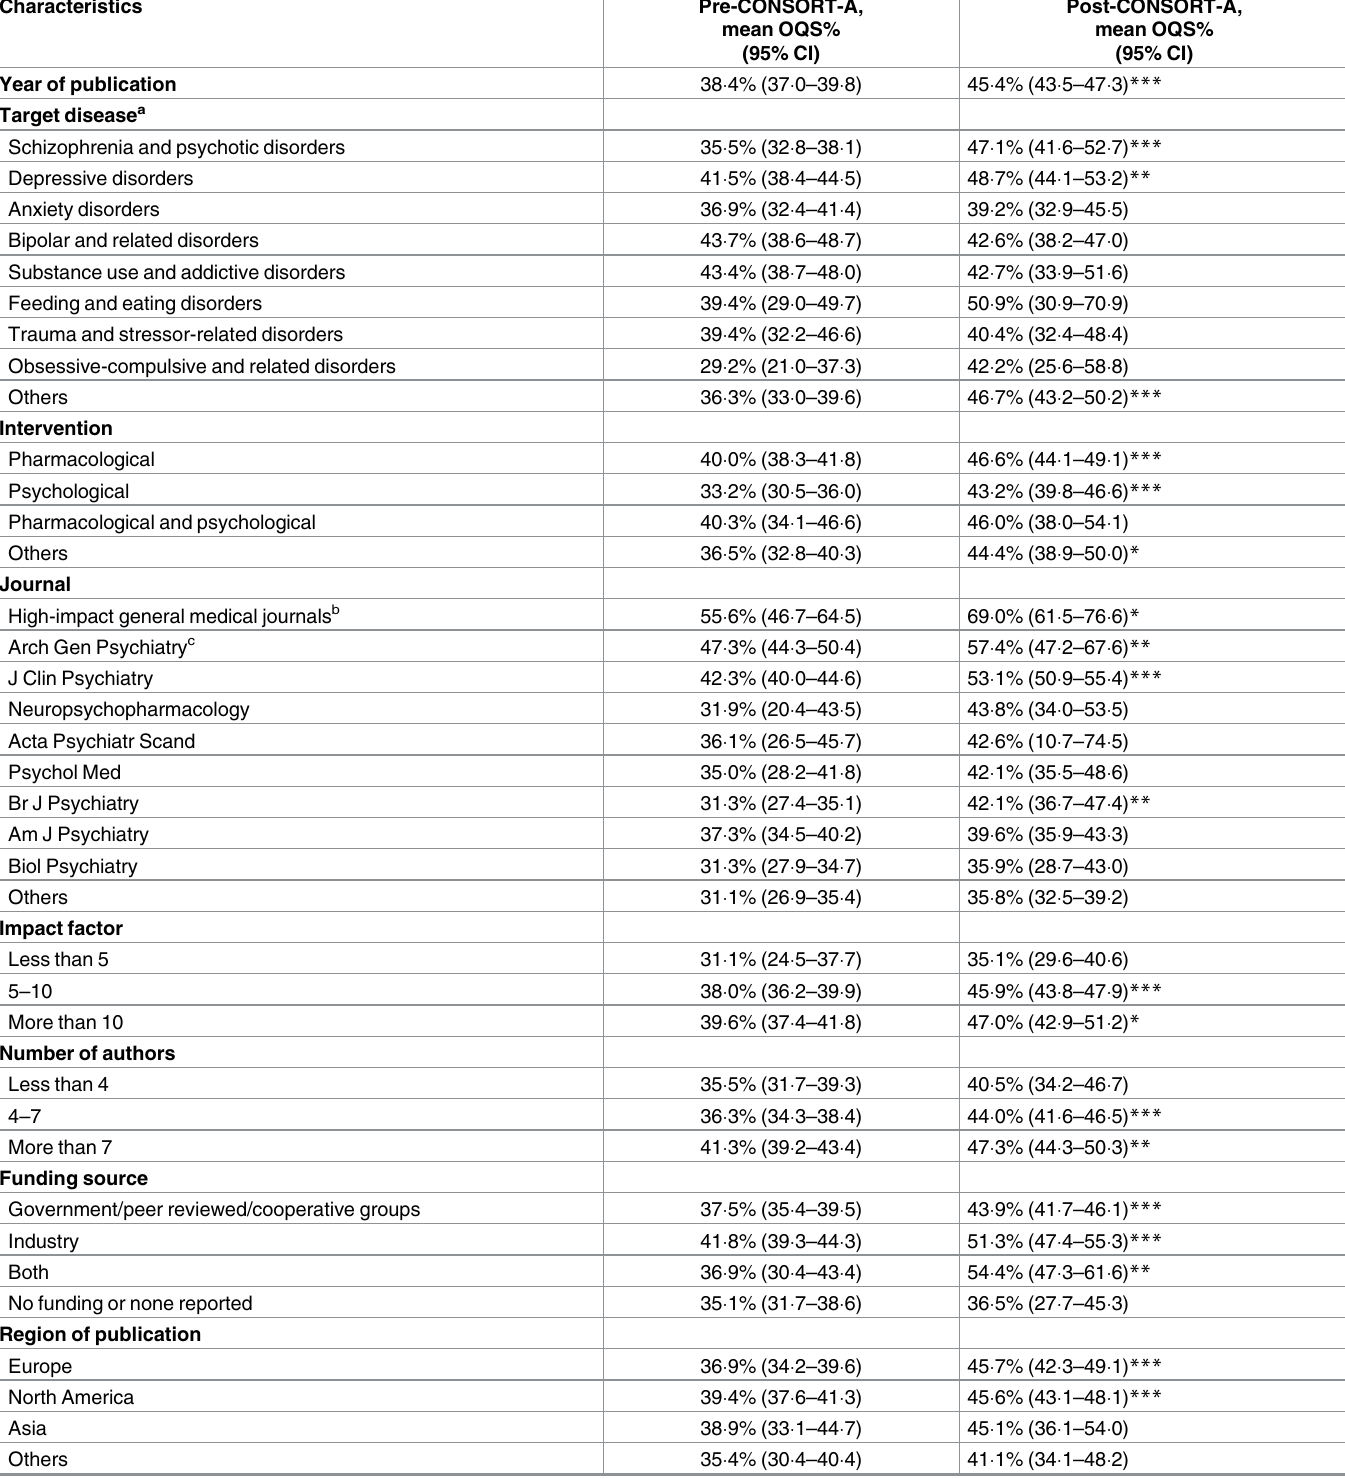
Table 2. Mean overall quality score (OQS) on a modified percentage scale according to the characteristics of the included psychiatry RCT abstracts.